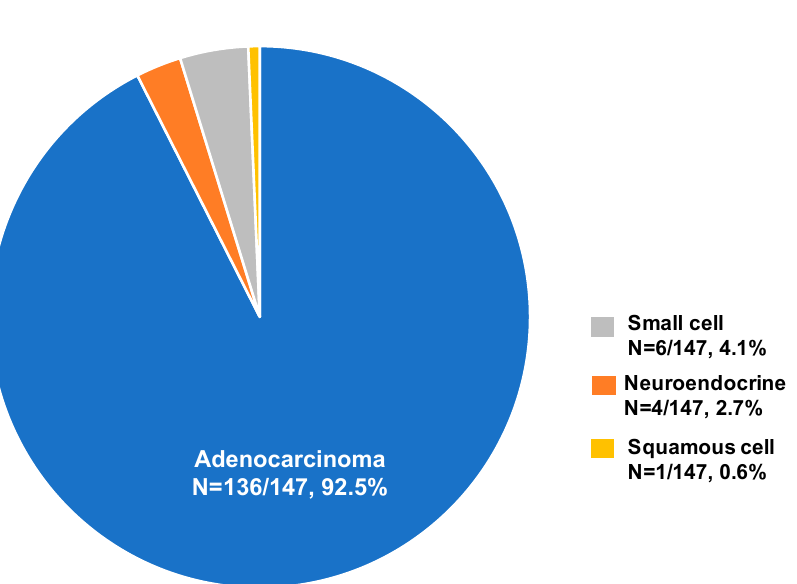
Figure 6. The histologic diagnosis of tissue acquired in biopsies.